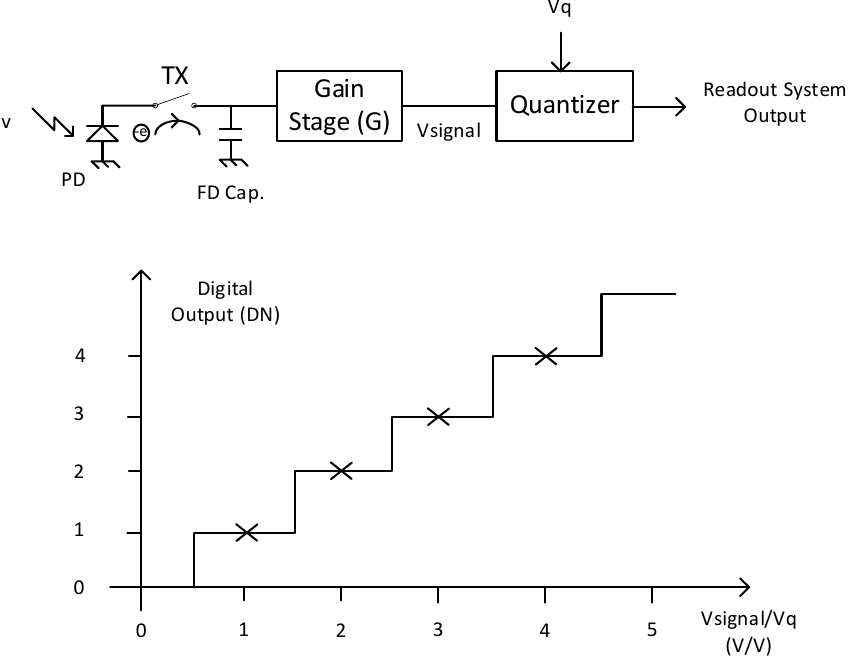
Figure 7. Simple illustration of the charge-to-signal conversion process on a modern low-noise CIS.